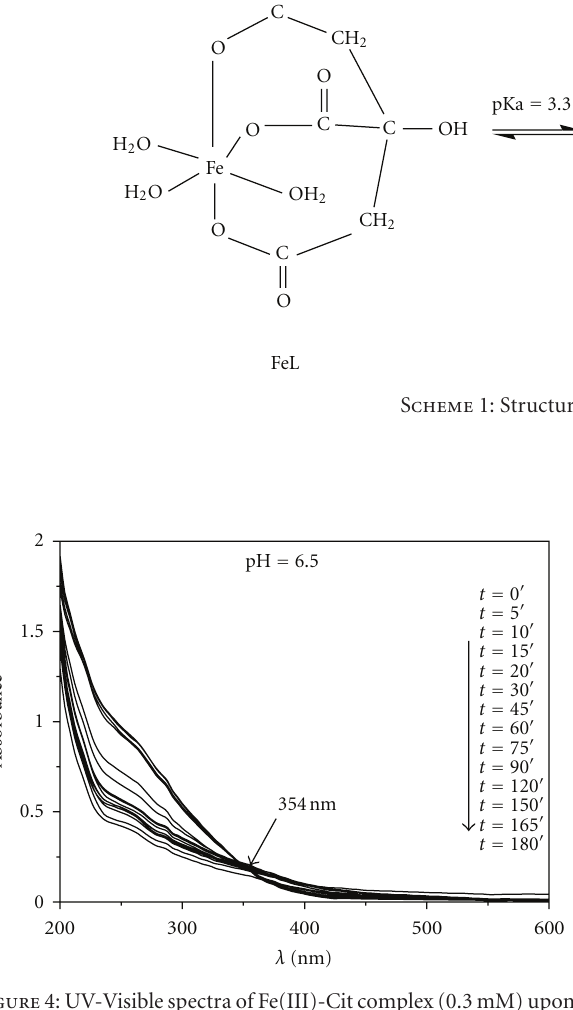
Figure 4: UV-Visible spectra of Fe(III)-Cit complex (0.3mM) upon irradiation at 365 nm. pH = 6.5.